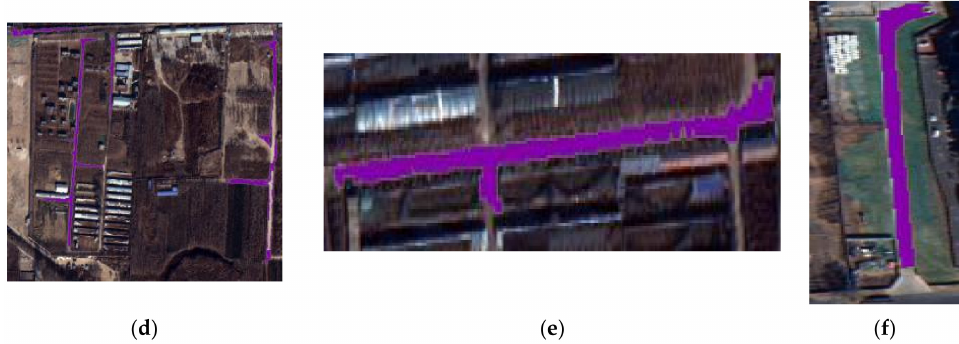
Figure 20. Classification results of aspect ratio features: ( a – f ) he result of separating linear features such as rural roads with the aspect ratio.